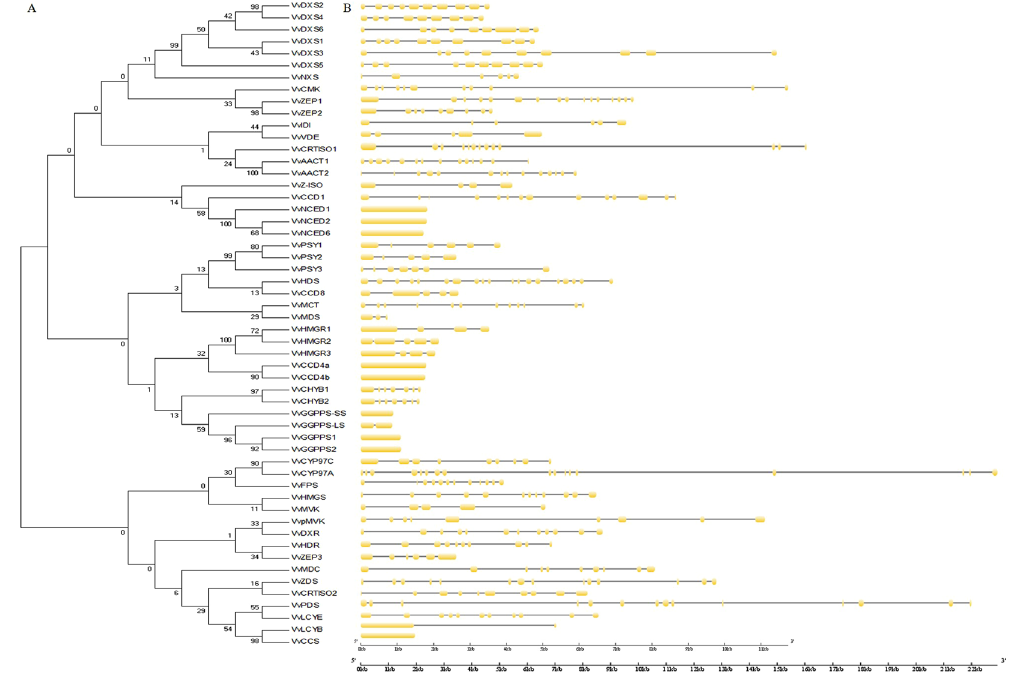
Figrue 3. Structure analysis of carotenoid metabolic genes. ( A ) NJ phylogenetic tree of carotenoid metabolic proteins. ( B ) Exon-intron structure of carotenoid metabolic genes. Two different legends were used, 4 genes with long genomic sequence ( VvPDS , VvZDS , VvCRTISO1 and VvCYP97A ) used the long legends, and the others genes used the short legends. Yellow indicates exons; black indicates introns.